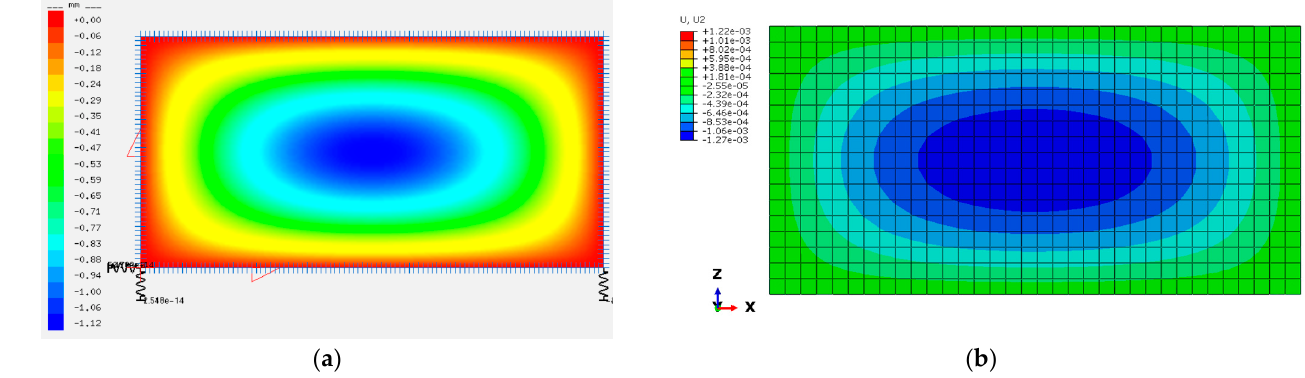
Figure 3. Validation of the flat IGU model (‘summer’ load case): ( a ) deflections obtained from the SJ-Mepla software (values in mm); ( b ) deflections obtained from the ABAQUS software (values in m).